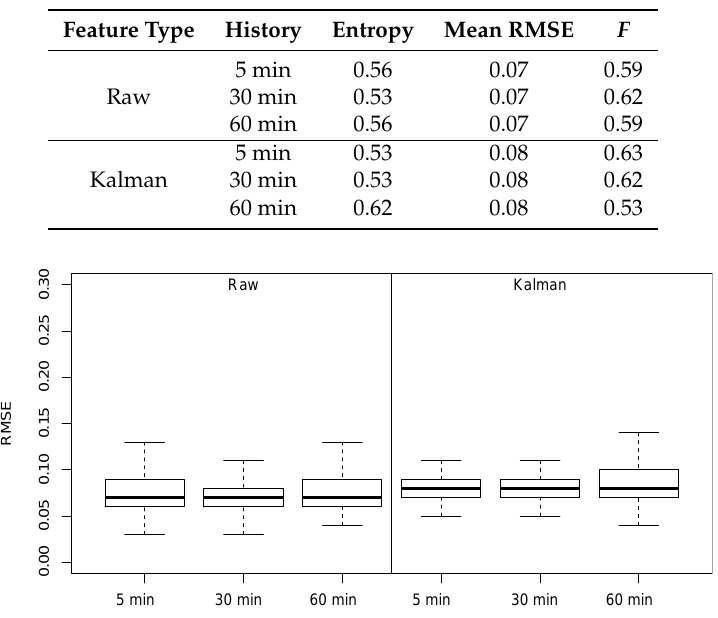
Table 1. Performance details of the baseline approaches, considering one model per road segment.